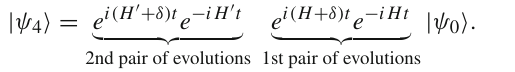
Fig. 14 Left: Time evolution of negative of logarithm of higher fold LE and complexity for Inverted Oscillator ( m = 1 ,λ = 5 (green), 10 (purple), 20 (red), δλ = 0 . 001). The solid line is complexity and